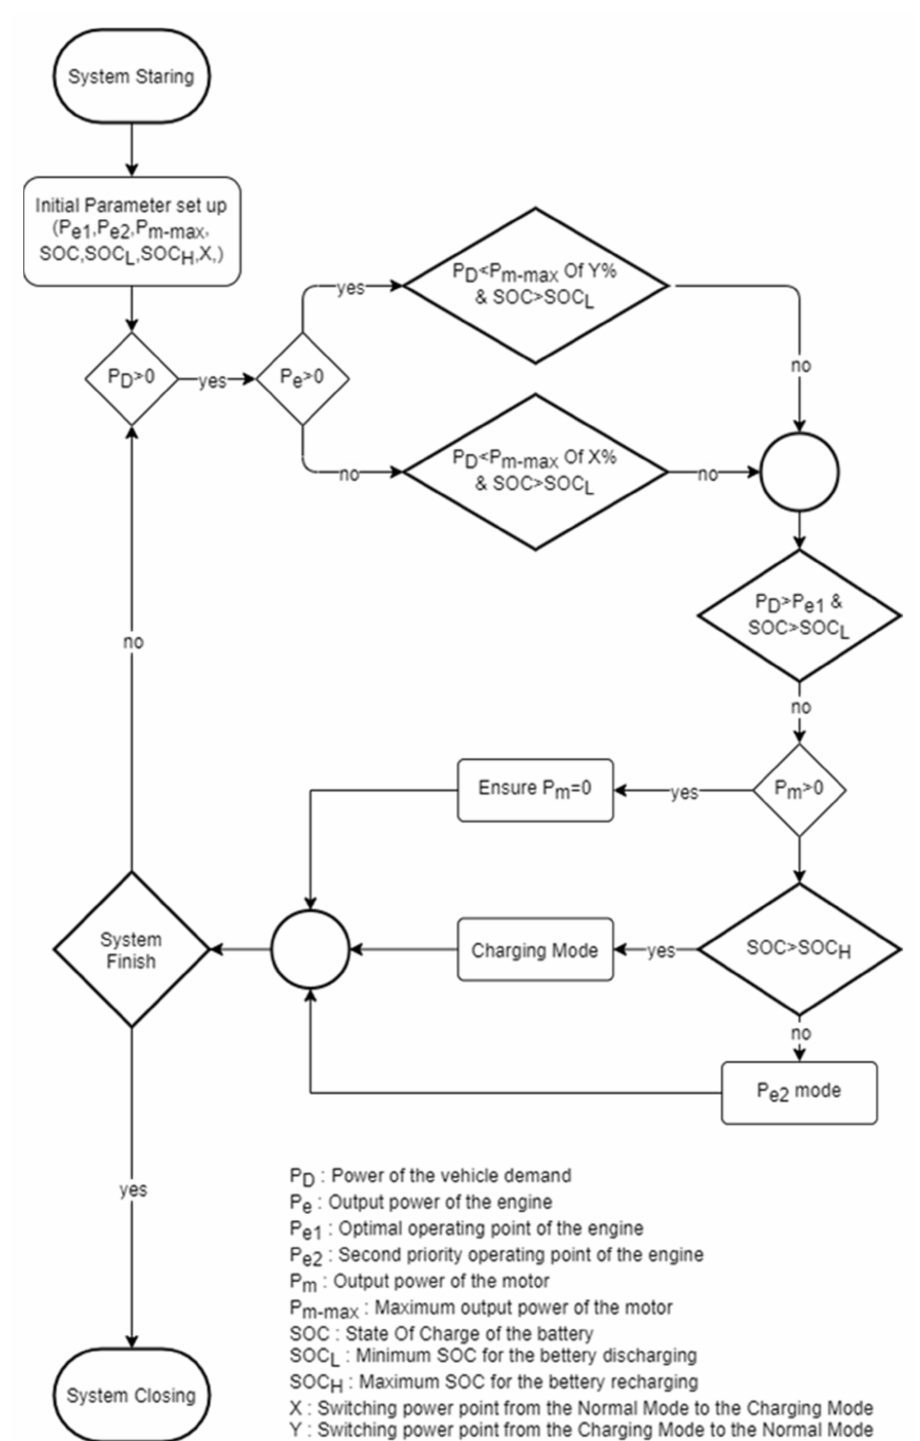
Figure 3. Flowchart of the engine output control strategy. Dual output: The control flow is shown in Figure 4. When the driver’s power demand exceeds the optimal operating point of the ICE and the SOC is greater than the reference value, the electric motor is used to assist the ICE to meet the vehicle’s power